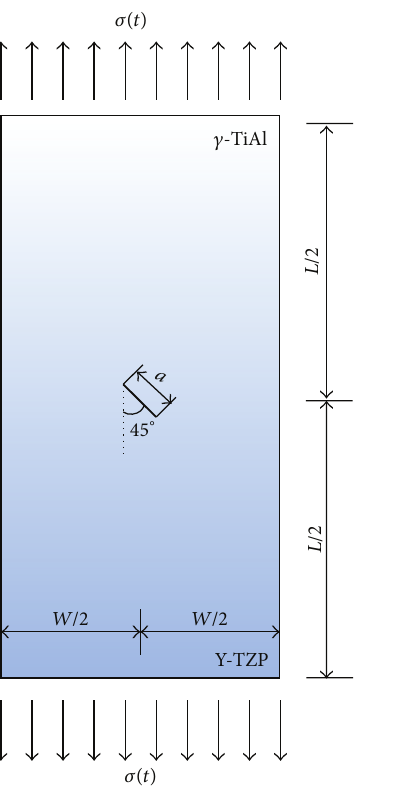
Figure 7: Inclined-crack functionally graded plate under impact loading.